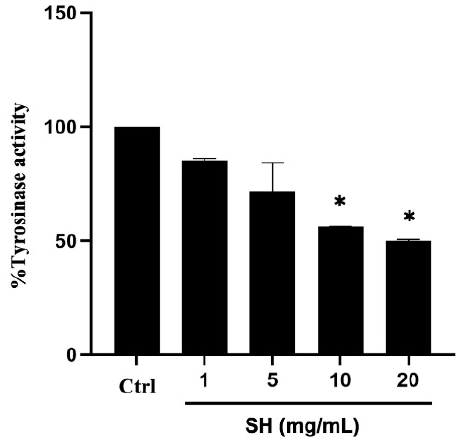
Figure 4. The enzymatic function of tyrosinase contained in the cellular lysate from human MNT1 cells was determined after the adding of its substrate, L -DOPA (2 mM) with or without sericin hydrolysates (SH) prepared using Alcalase ® . After further incubation at 37 °C for 2 h, Alcalase ® - hydrolyzed sericin at 10–20 mg/mL significantly inhibited enzymatic activity of human tyrosinase. Data are presented as means ± SEM from three independent experiments. * p < 0.05 versus non- treated cells (Ctrl).